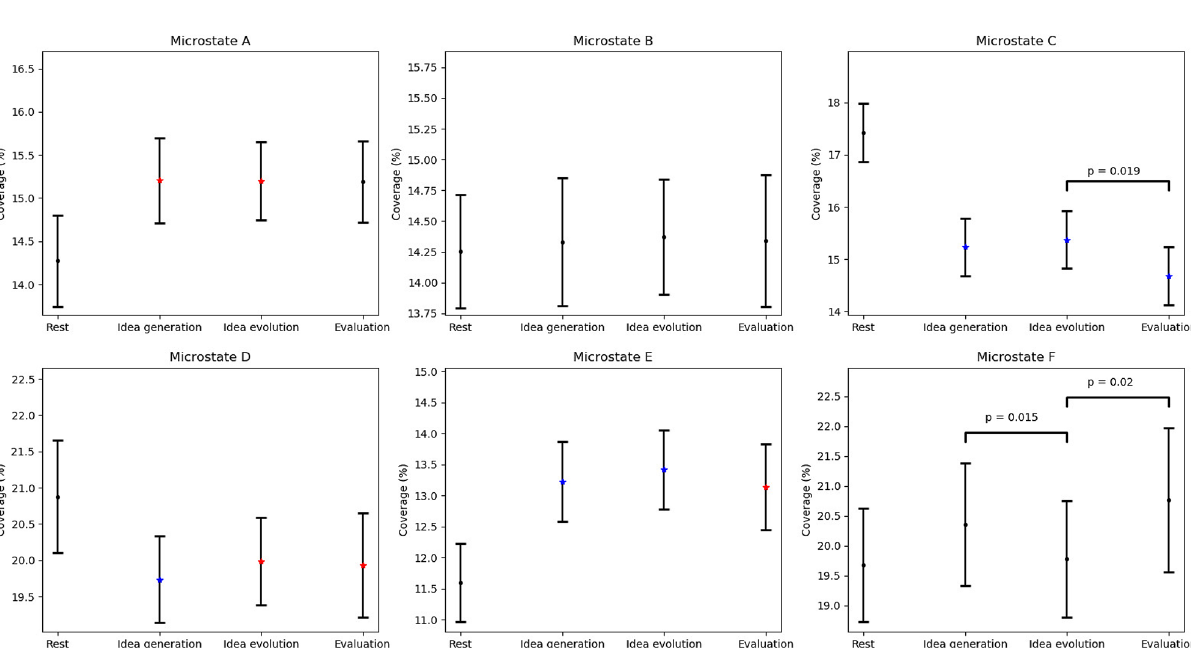
Figure 5. Error bar of microstate coverage for rest, idea generation, idea evolution, evaluation, and differences between the conditions. P-values are represented by the black dots ( p > 0.05 ), red asterisks ( p < 0.05 ), green asterisks ( p < 0.01 ), and blue asterisks ( p < 0.005 ) between rest and the three modes thinking. P-values are annotated between idea generation, idea evolution, and evaluation.